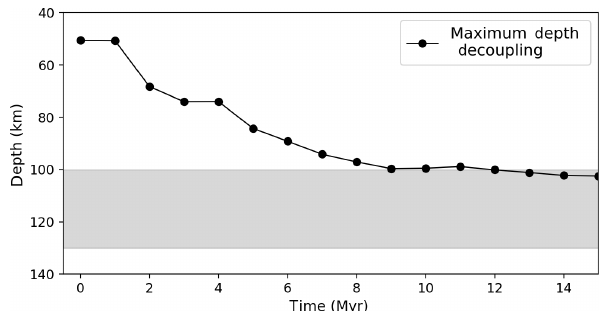
Figure 9. Evolution of the maximum depth of decoupling (MDD). As the mantle wedge cools, it progressively stagnates, driving deeper decoupling within the subduction interface. The grey region in the figure shows the depth interval over which the subduction in- terface transitions to the background mantle rheology as prescribed with a cosine taper (see Sect. 4). Results are from the same model as shown in Fig. 6a, i.e. an EF model with W max = 1 . 9 × W init